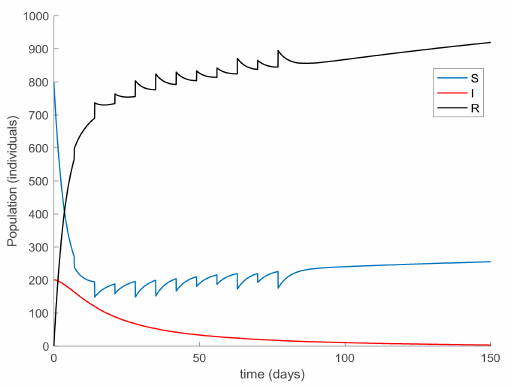
Figure 19. Evolution of all the subpopulations when a variable and limited-in-time impulsive vaccination of the susceptible individuals one day per week is added to the previous actions.